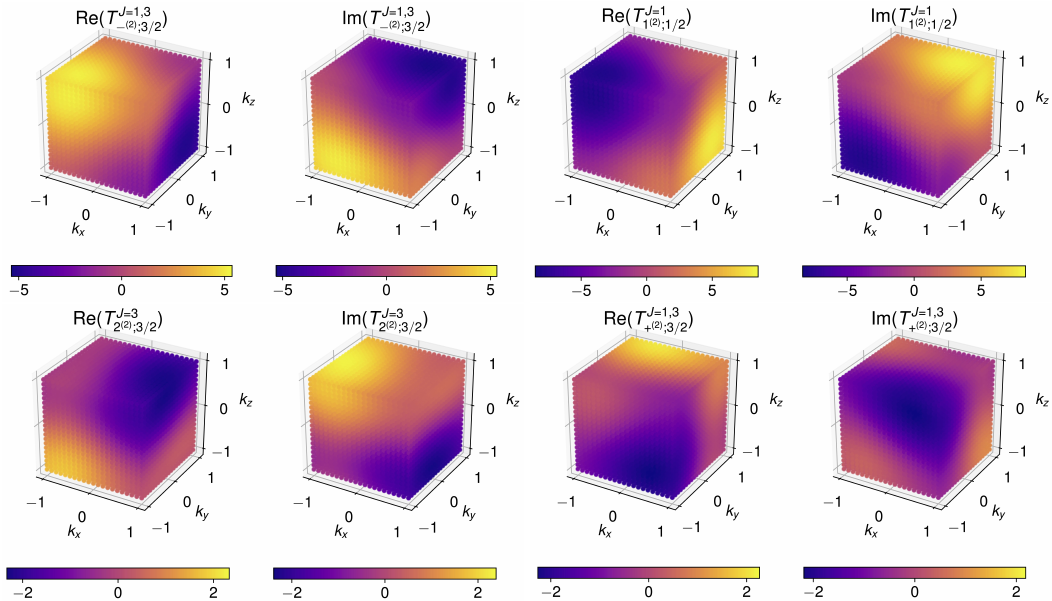
Figure 8: Momentum space distribution of the superconducting states ( j = 2 com- ponent) arising from the novel Kondo interaction presented in Table 2 and Fig. 2.